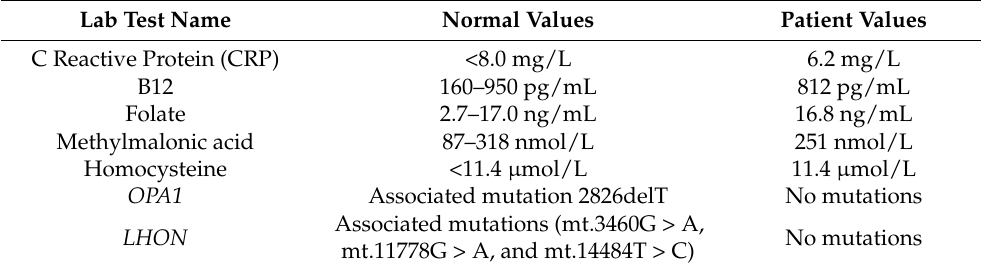
Table 1. Demonstrating patients extensive blood work up for nutritional and common genetic causes of optic neuropathy. Blood work up for inflammatory, genetic, and reversible optic neuropathies with normal and patient